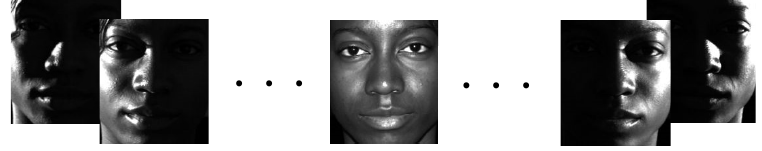
Figure 3. Face image with an azimuth angle of +130° to −130°.